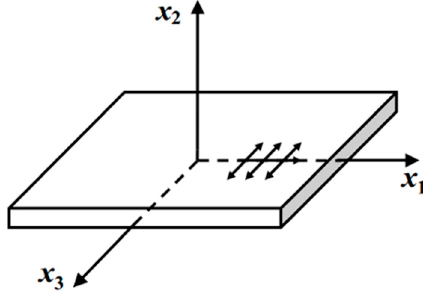
Figure 1. Shear horizontal (SH) wave mode propagation.